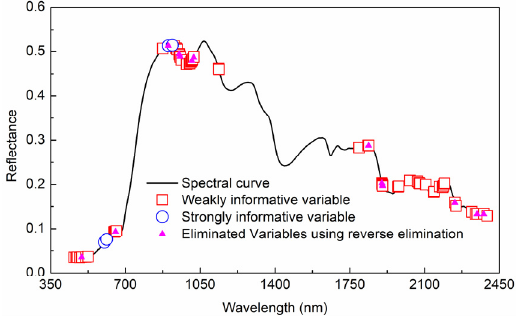
Figure 4. Selection of characteristic wavelength using IRIV based on open-field cultivation.